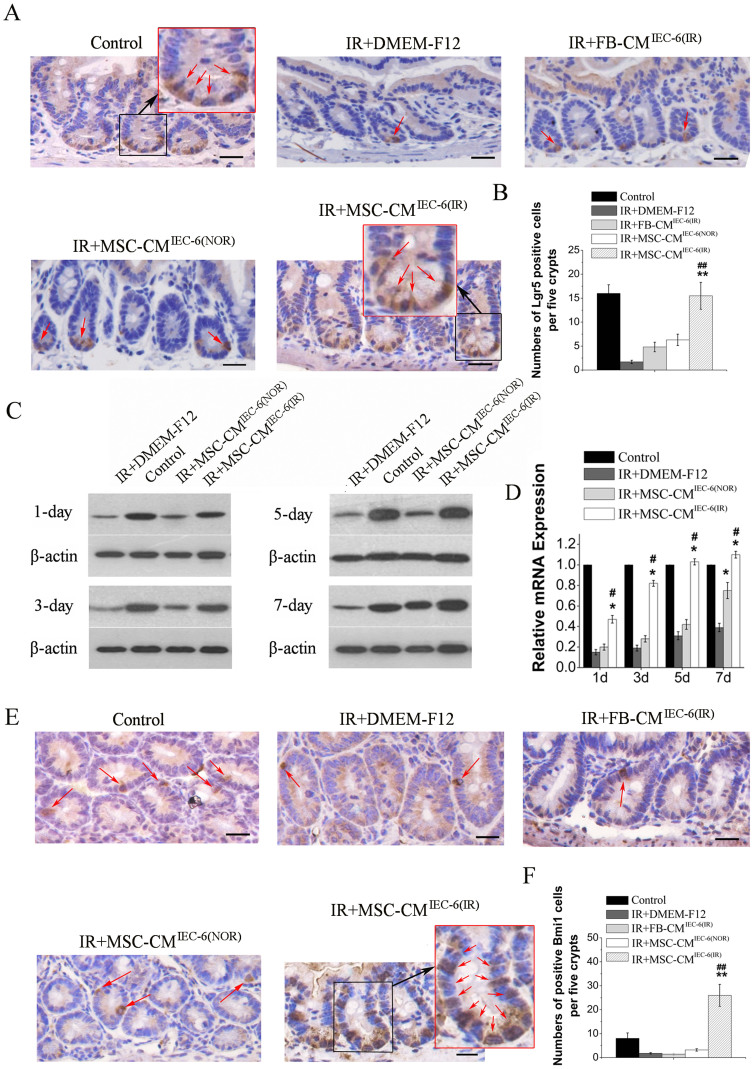
MSC-CMIEC-6(IR) promotes regeneration of intestinal stem cells (ISCs) after radiation.(A) Immunohistochemical staining with Lgr5. Intestinal tissue samples were collected and analyzed 3 days after radiation. Scale bars 25 μm. (B) Quantification of Lgr5-positive cells. n = 3 in each group. The number of positive cells in 5 crypts was scored in 100 crypts per section and reported as mean ± SD. **, P < 0.05 versus IR + DMEM-F12, ##, P < 0.05 versus IR + MSC-CMIEC-6(NOR). (C) The protein levels of Lgr5 in the jejunal mucosa of rats were detected by Western blot assays at 1, 3, 5, 7 days after radiation with β-actin as the internal control. The full-length blots are presented in Supplementary Figure 1A. (D) Lgr5 mRNA expression in the jejunal mucosa of rats after radiation was evaluated by quantitative real-time RT-PCR. β-actin was used as a loading control. Values represent means ± SD; n = 3 in each group. *, P < 0.05 versus IR + DMEM-F12, #, P < 0.05 versus IR + MSC-CMIEC-6(NOR). (E) Immunohistochemical staining with Bmi1. Intestinal tissue samples were collected and analyzed 3 days after radiation. Scale bars 25 μm. (F) Quantification of Bmi1-positive cells. n = 3 in each group. The number of positive cells in 5 crypts was scored in 100 crypts per section and reported as mean ± SD. **, P < 0.05 versus IR + DMEM-F12, ##, P < 0.05 versus IR + MSC-CMIEC-6(NOR).